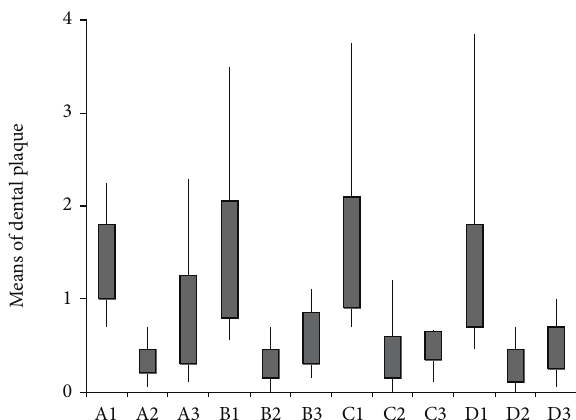
Figure 1: Mean values of biofilm for four solutions (A: Control; B: Plax; C: B. dracunculifolia extract and essential oil; D: Listerine) in three different experimental times (1: preliminary: basal level; 2: immediately after: measured after one-time use of mouthwash; 3: one week: a full week of mouthwash